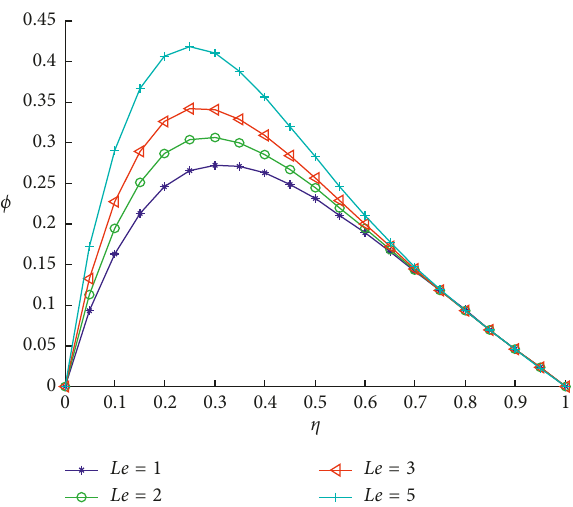
Figure 17: Effect of the Brownian motion parameter on 0 . 5 , c 0 . 1 ,Pr the concentration profile when A (cid:31) (cid:31) (cid:31) 0 . 05 ,M